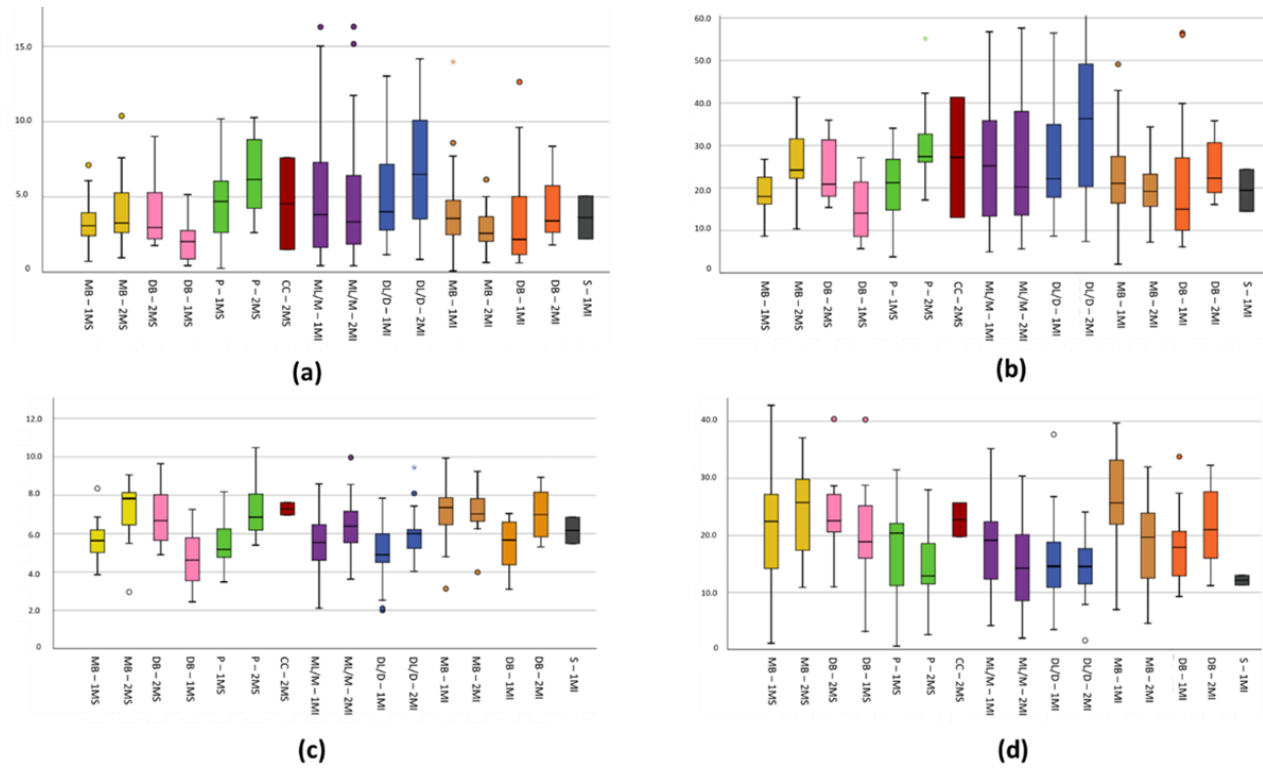
Figure 8. Box plot for comparison of root canal variables: In axis Y outlined ( a ) Length (mm), ( b ) Angle ( ◦ ), ( c ) Surface (mm 2 ), ( d ) Volume (mm 3 ). Axis X is described as root canals 1MS (Maxillary 1st molar), 2MS (Maxillary 2nd molar), 1MI (Mandibular 1st molar), 2MI (Mandibular 2nd molar), MB (mesiobuccal), DB (distobuccal), P (palatal root), ML/M (mesial), DL/D (distal), S (supernumerary). The MB and P canals of the maxillary molar present means of 6.46 ( ± 1.15) and 6.39 ( ± 1.33), being greater than the DB canals, while in the lower maxilla the buccal canals of the mesial roots presented a higher mean (7.12 ± 1.27) than the distal or mesiolingual canals. The minimum value recorded was 2.44 mm, corresponding to the DB root of the upper second molar, while the maximum value was 10.8 mm. Additionally, two lingual collateral canals of the mesial root of the maxillary second molar were found with a mean of 7.291 ( ± 0.458). The supernumerary root canals of the lower first molars presented a mean of 6.167 ( ±